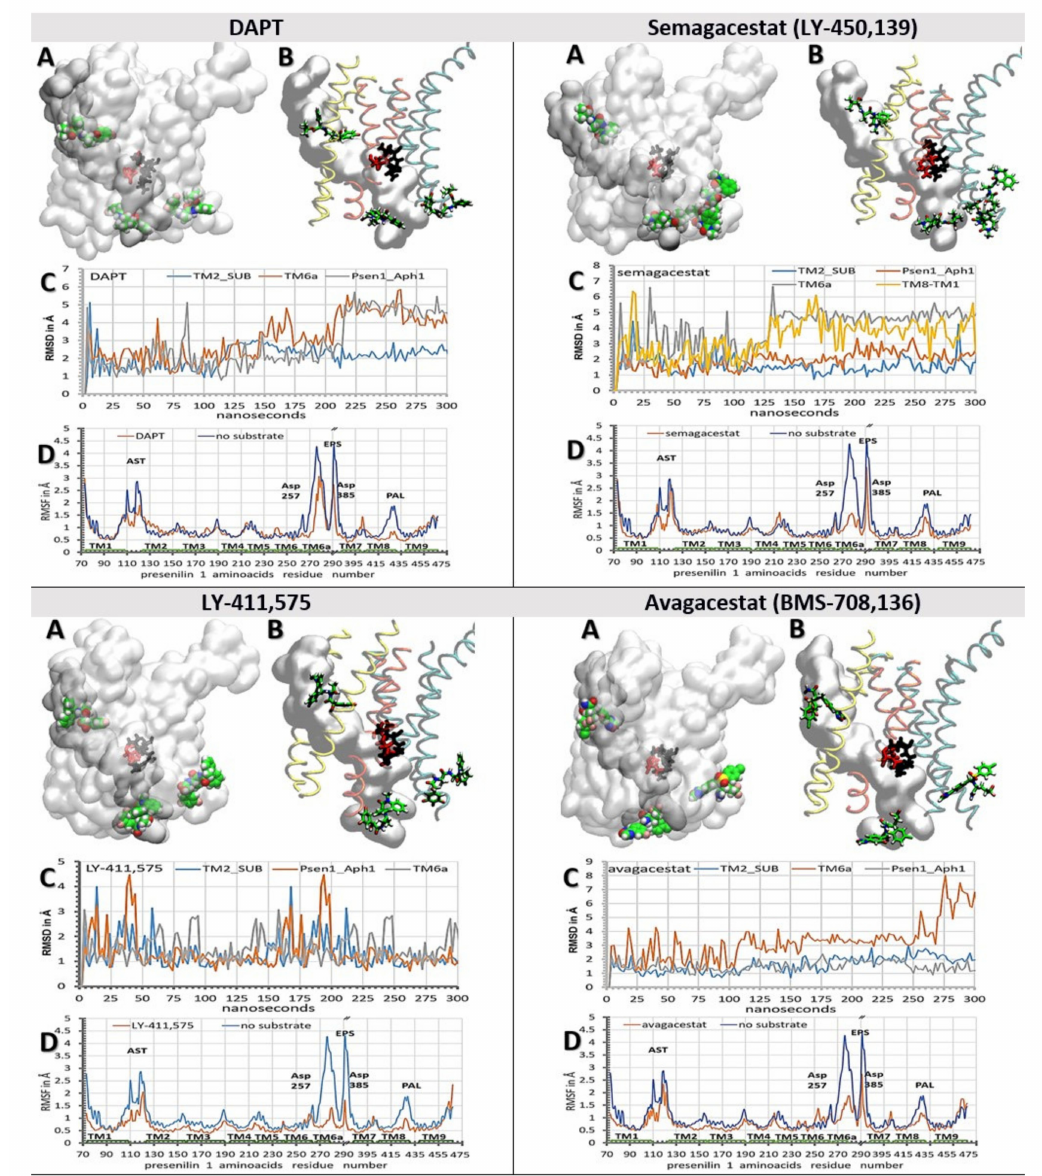
Figure 5. ( A – D ) Binding interactions between the biphasic drugs and γ -secretase in a complex with its substrate (PDB: 6IYC) [38]. The all-atom molecular dynamic studies [51] started with γ -secretase in a complex with different biphasic drugs from the molecular docking calculations (Figure 4) [48]. ( A , B ) Different drugs can bind to different sites next to the substrate. The presenilin structures are shown as transparent surfaces. Buried under the surface in the active site tunnel are the substrate (gray surfaces), the active site Asp 257 and Asp 385 (red licorice), and the PAL motif (black licorice, Pro 435, Ala 434, Leu 433). The drug molecules are shown as: carbon, green; oxygen, red; nitrogen, blue; fluorine and chlorine, pink, in order to make the structures underneath the surface visible. ( B ) TM2 and TM3 are shown in yellow; TM6, TM6a, and TM7 are shown in orange; TM8, TM9, and TM1 are shown in cyan. ( C ) RMSD values for the drugs bound at different sites are shown as a function of the simulated molecular time [51]. The steep increases in the RMSD values indicate the sliding of the drugs in the binding sites, while the fluctuations in the RMSD values indicate the relative mobility of the drugs in their binding sites. ( D ) The RMSF values for the individual amino acids show how the drugs can decrease the protein mobility at different sites [40,41]. Different structural elements are mapped on the graph: TM1-TM9, Trans-Membrane helix 1 to 9; AST, membrane-embedded opening of the Active Site Tunnel; EPS, Endo-Proteolytic Site; PAL motif (Pro 435, Ala 434, Leu 433) [42], and Asp 257 and Asp 385 in the active